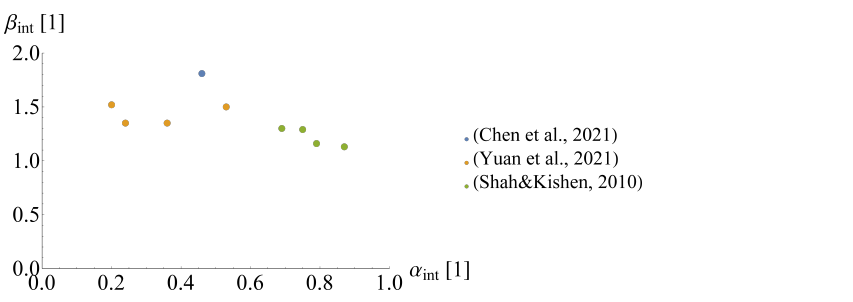
Figure 7. The relationship between the bond efficiency coefficient and a decrease in the fracture energy.